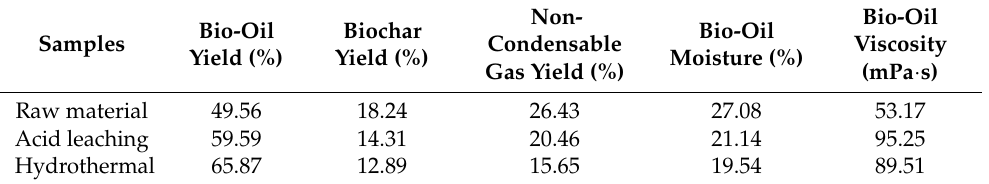
Pyrolysis characteristics of eucalyptus with and without acid leaching and hydrothermal